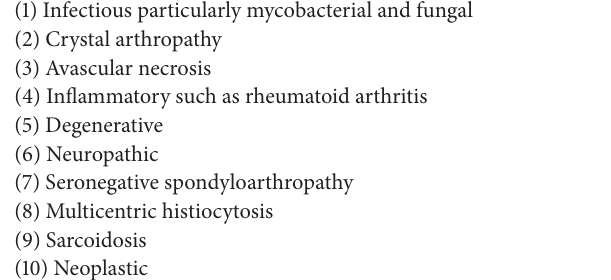
Figure 3: (a) Papillary, hyperplastic, chronically inflamed synovium is shown with abundant fibrin covering the surface and multiple fragments of bone being degraded by histiocytes and multinucleated giant cells. (b) At higher magnification, fibrin is seen on the surface of the synovium with a hyperplastic synovium consistent with chronic inflammation. (c) Fibrin and bone are detailed at 40x magnification showing multiple bone fragments which is typical of a rapidly destructive joint process. (d) Bone is seen being further broken down by multinucleated giant cells. Table 3: Rheumatoid arthritis classification Table 2: Major differential diagnosis of rapidly destructive coxarthrosis.